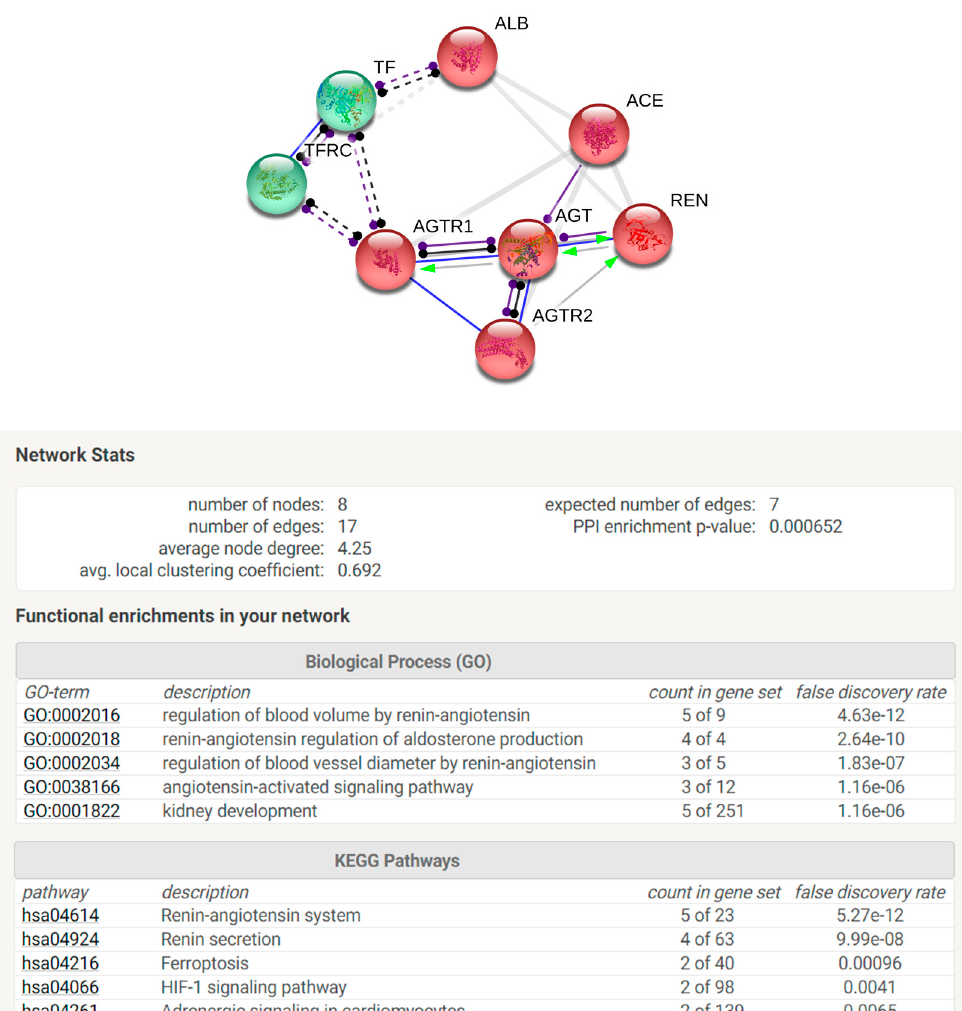
Figure 5. STRING analysis of the differentially abundant proteins reporting protein network with relative stats and functional enrichment by Biological Process and KEGG pathways.